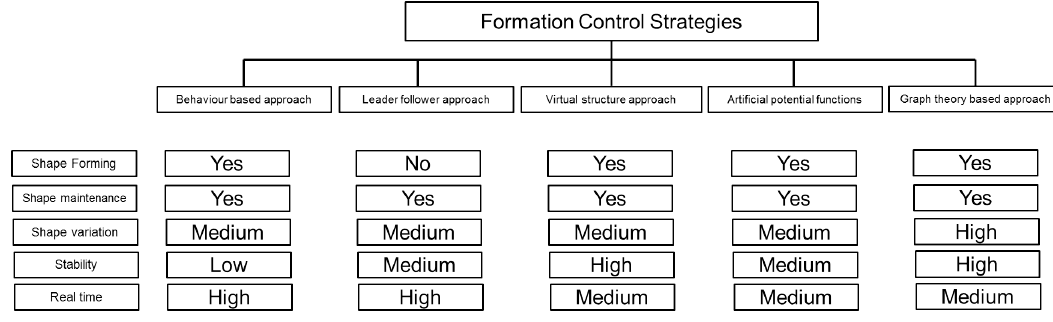
Figure 4. Comparison of formation control strategies (Source: modified from